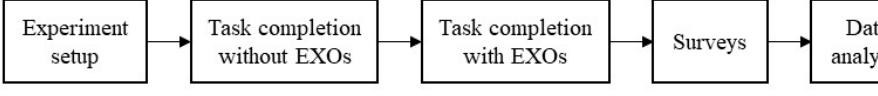
Figure 1. Pilot study flowchart.